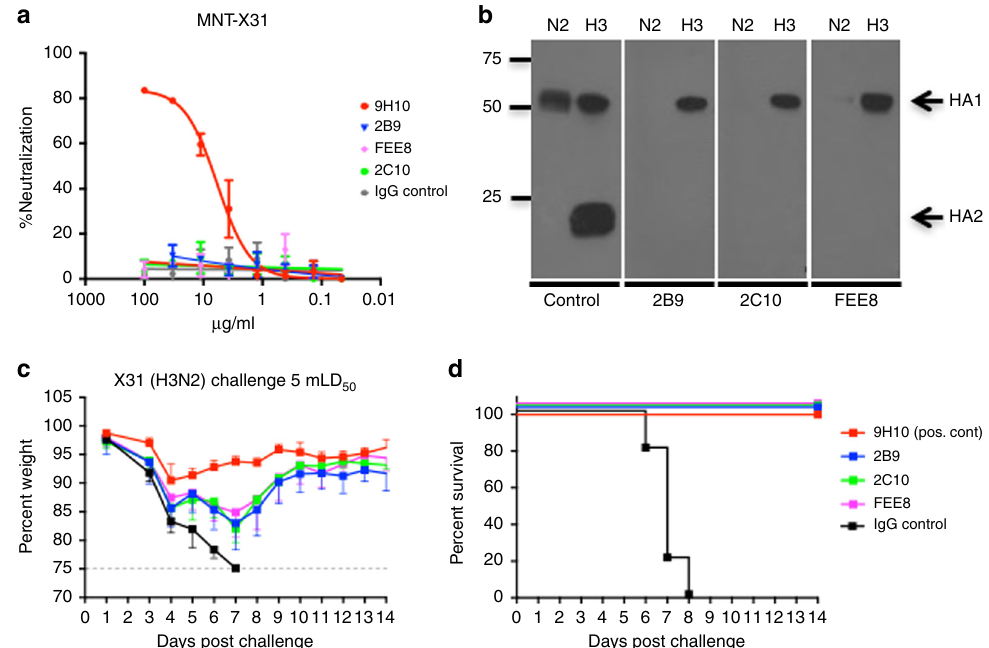
Fig. 1 Murine HA-speci fi c nonNAbs can protect mice from lethal IAV challenge. a The neutralization activities of 2B9, 2C10, and FEE8 were tested against X31 virus by microneutralization assay on MDCK cells. Values represent mean ± SD of three independent experiments. b A western blot was performed against recombinant HK/68 H3 (cleaved by trypsin) and N2 protein using mAb 2B9, 2C10, or FEE8. For controls, mAbs XY102 and 12D1 were used to detect the HA1 and HA2 of HK/68 HA, respectively. An anti-histidine mAb was used to detect HK/68 NA. c , d The ability of nonNAbs to confer protection was tested against X31 infection in vivo. Groups of BALB/c mice ( n = 5) were injected with 15 mg per kg IP of each indicated mAb and then challenged intranasally (IN) with 5 mouse 50% lethal doses (mLD 50 ) of X31. Control IgG (22A6) is a murine mAb that recognizes glutathione S-transferase (GST). c The change in weights and ( d ) the survival curves are shown through a 14-day period. Values represent mean ±